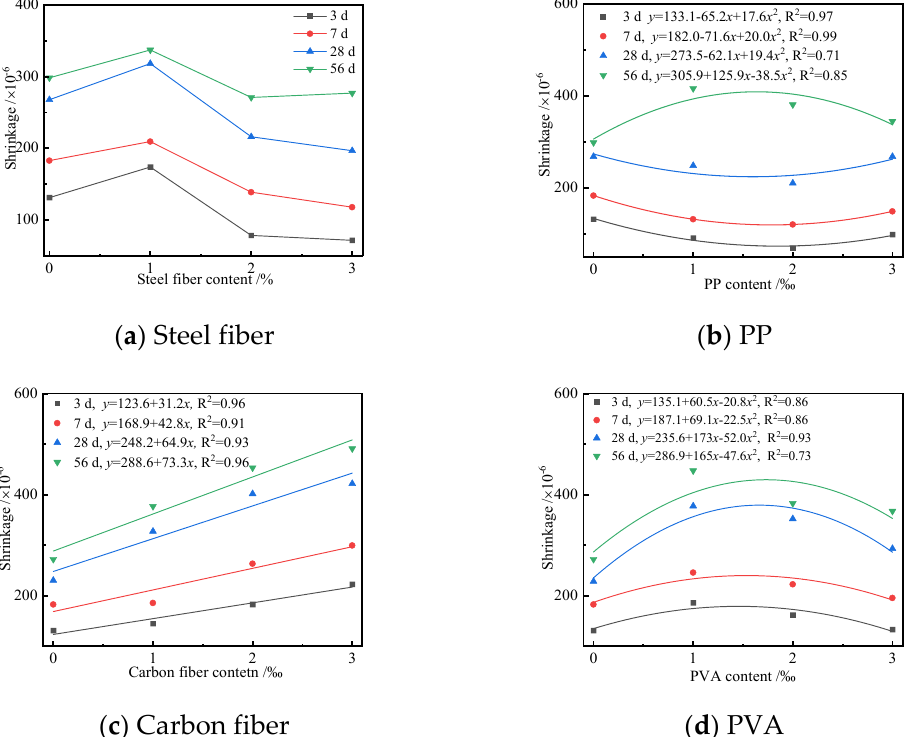
Figure 10. Shrinkage curves of the UHPC with different types and contents of fibers.